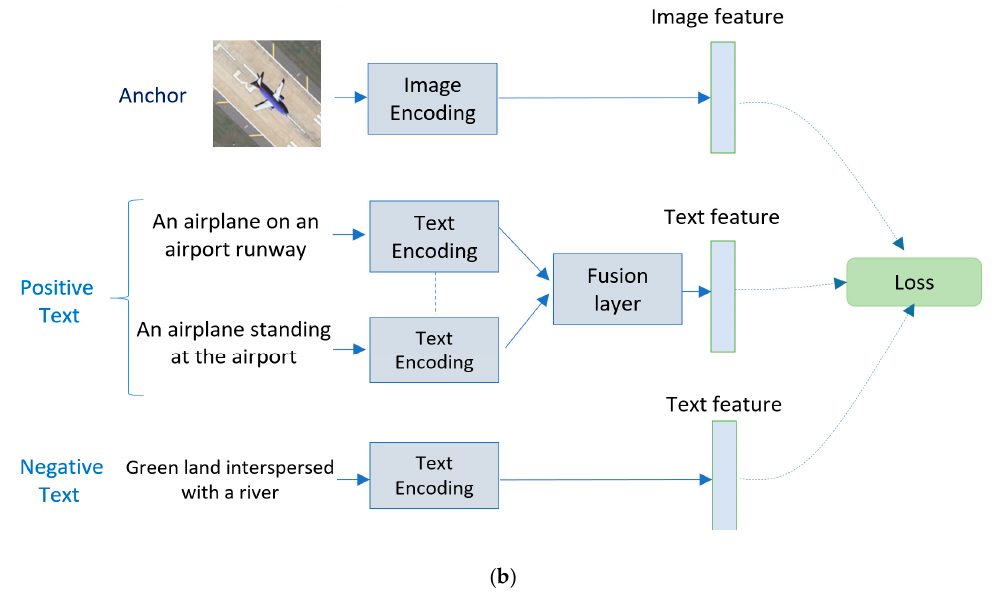
Figure 1. Flowchart of the proposed Deep Bidirectional Triplet Network (DBTN): ( a ) text as anchor, ( b ) image as anchor.